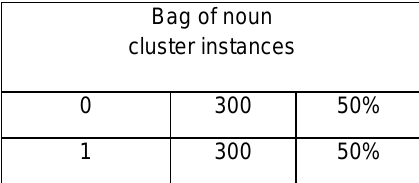
Table 2. Proposed clustering with